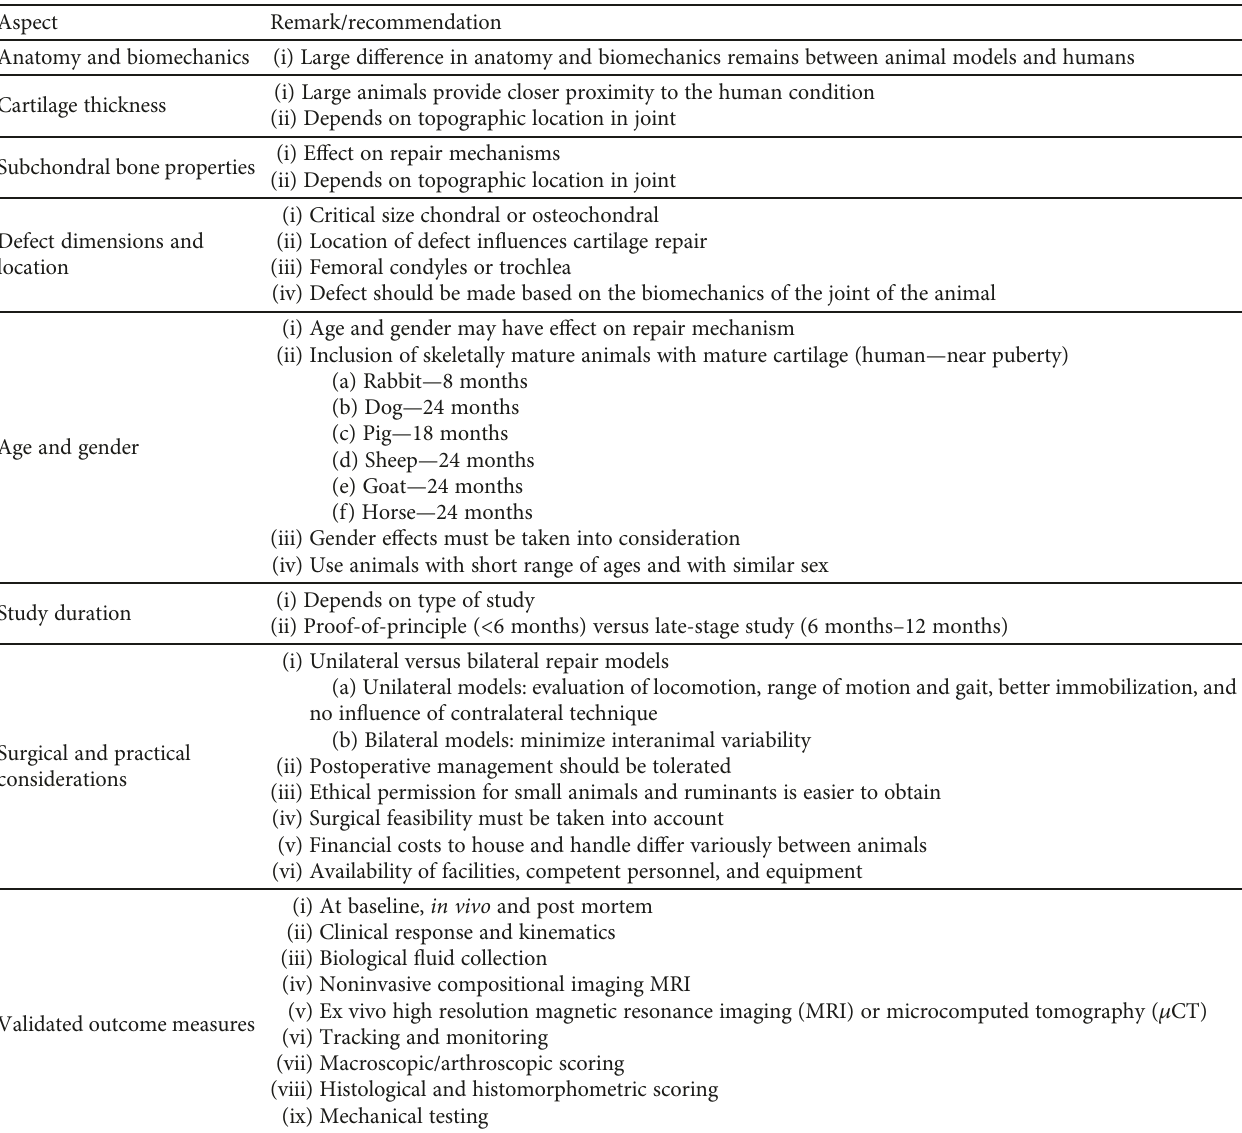
Table 1: Key factors for the selection of a translational animal model for cartilage